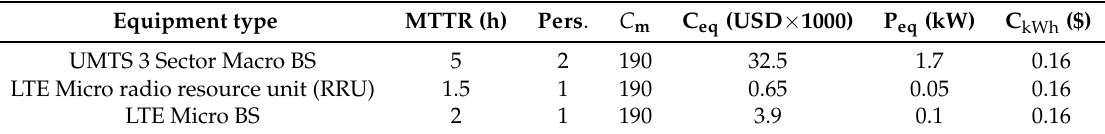
Table 6. Parameters used for the cost analysis. Mean time to repair: